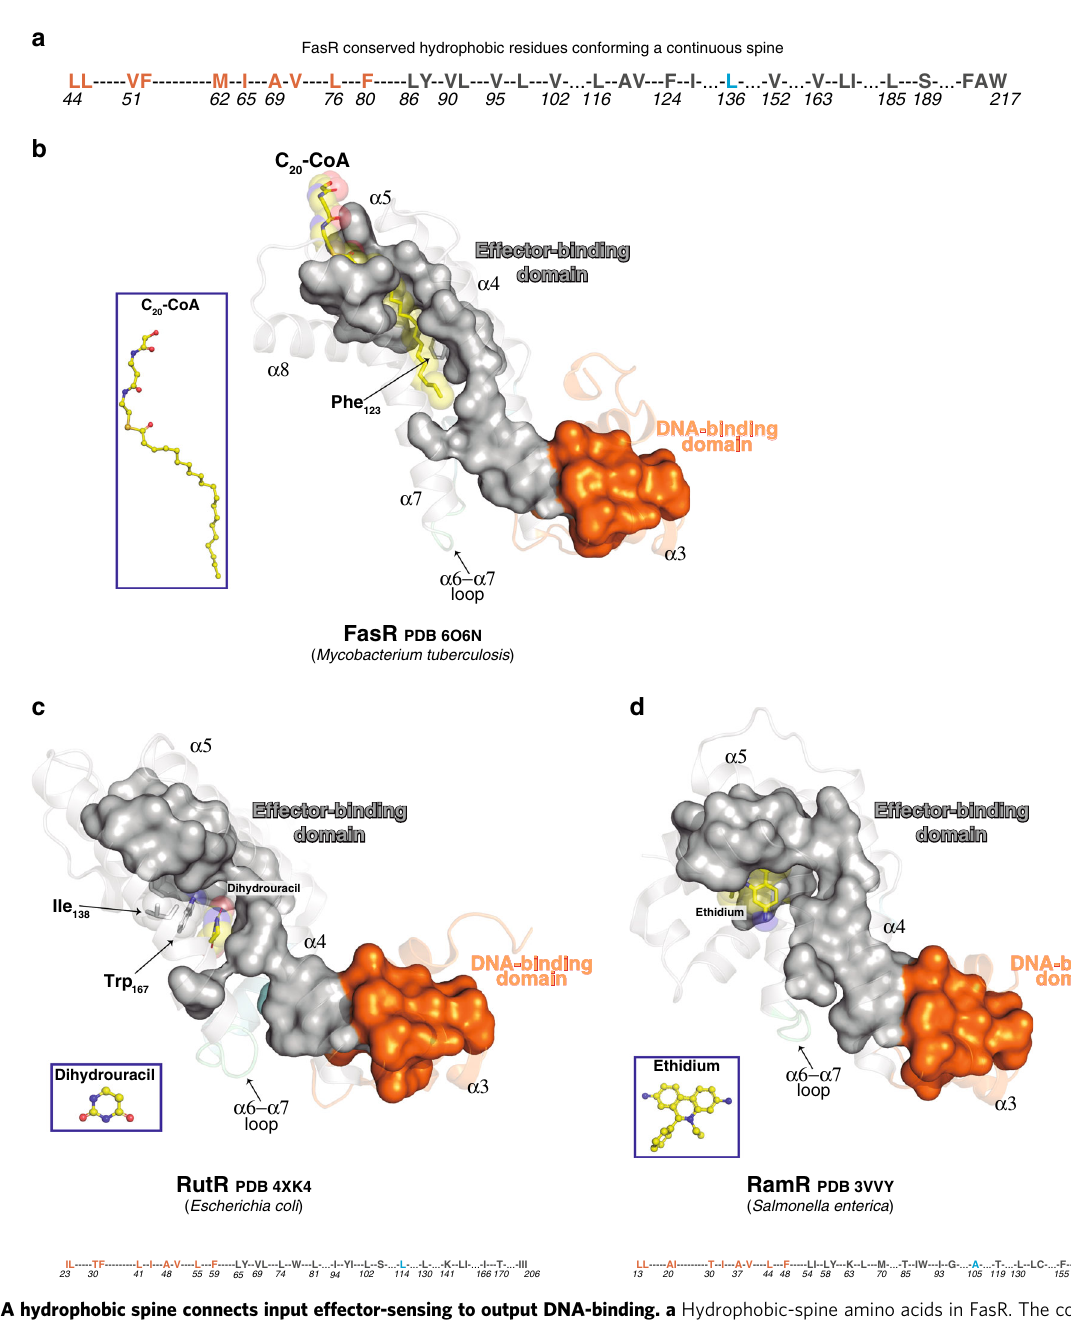
with NdeI and HindIII, extracted from the agarose gel, and inserted into the expression vector pET28a, as described by the manufacturer (Merck). The recombinant plasmids were transformed into BL21 CodonPlus(DE3)-RIL cells and transformants selected on LB agar plates with 50 μ g/ml kanamycin. DNA sequences of all genes were veri fi ed by Sanger sequencing.